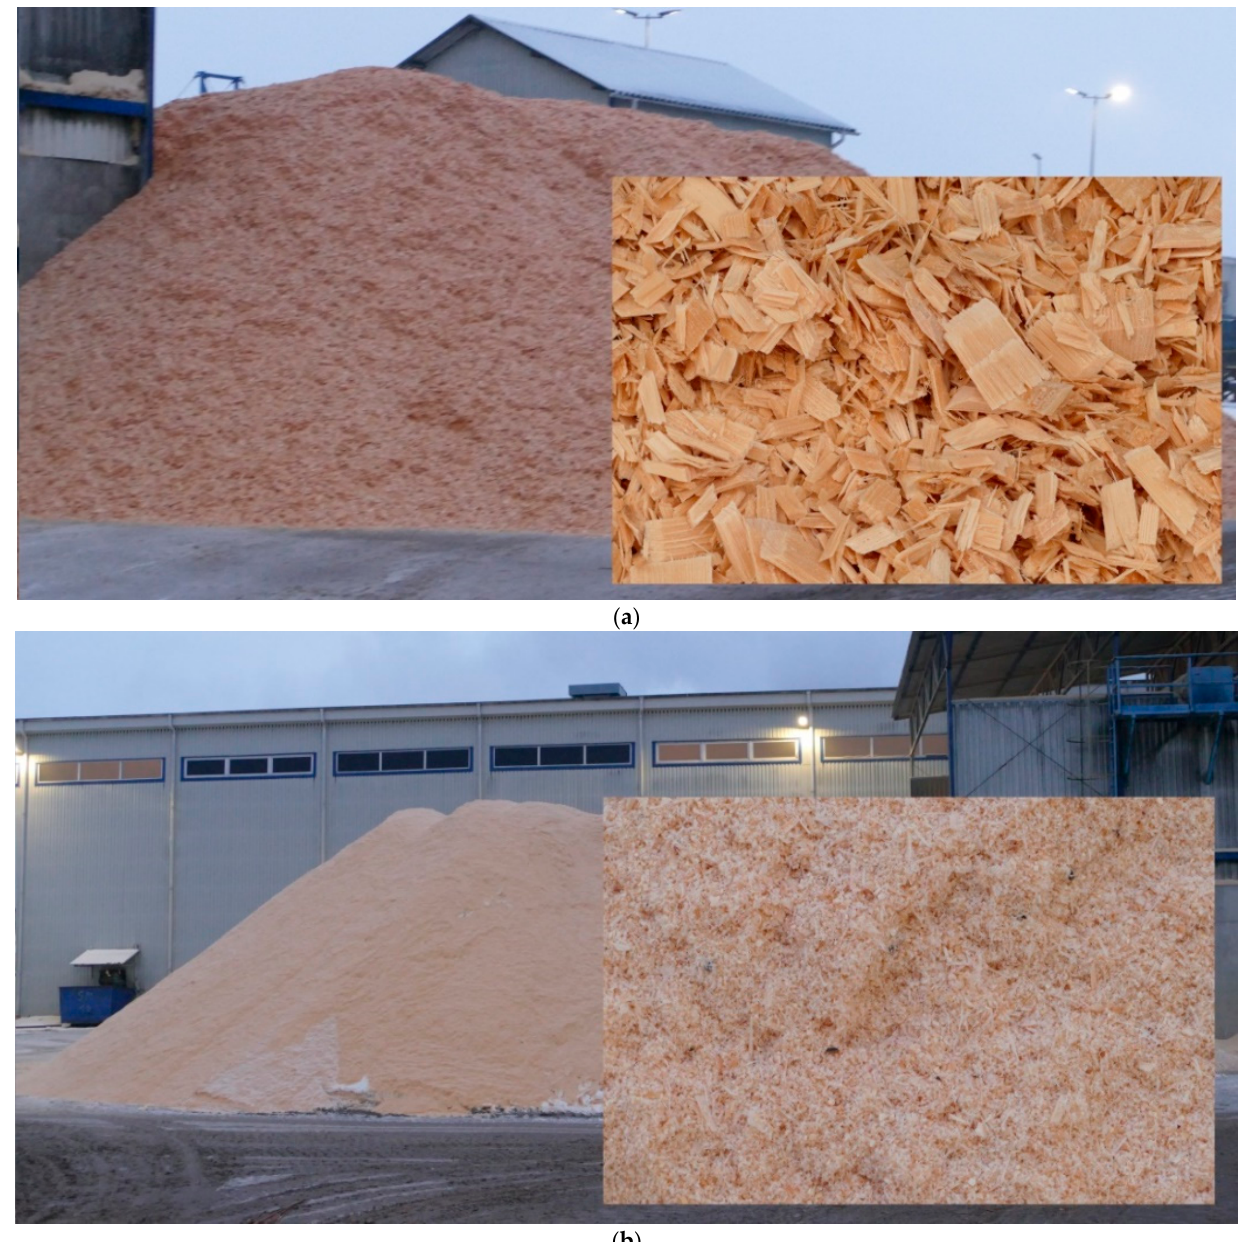
Figure 1. Wood biomass generated during the processing of roundwood and the method of its storage—chips ( a ) and sawdust ( b ).